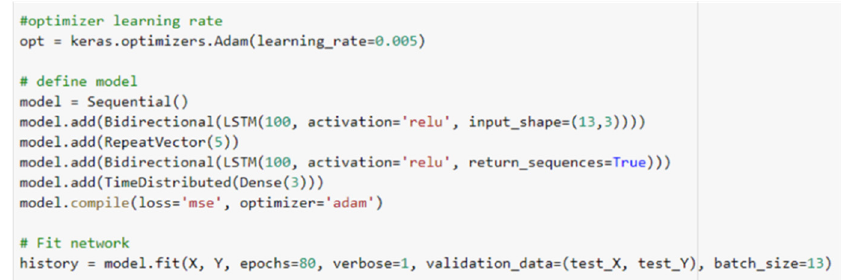
Figure 8. Coding (carried out in Keras) for training one of our encoder-decoder BiLSTM.